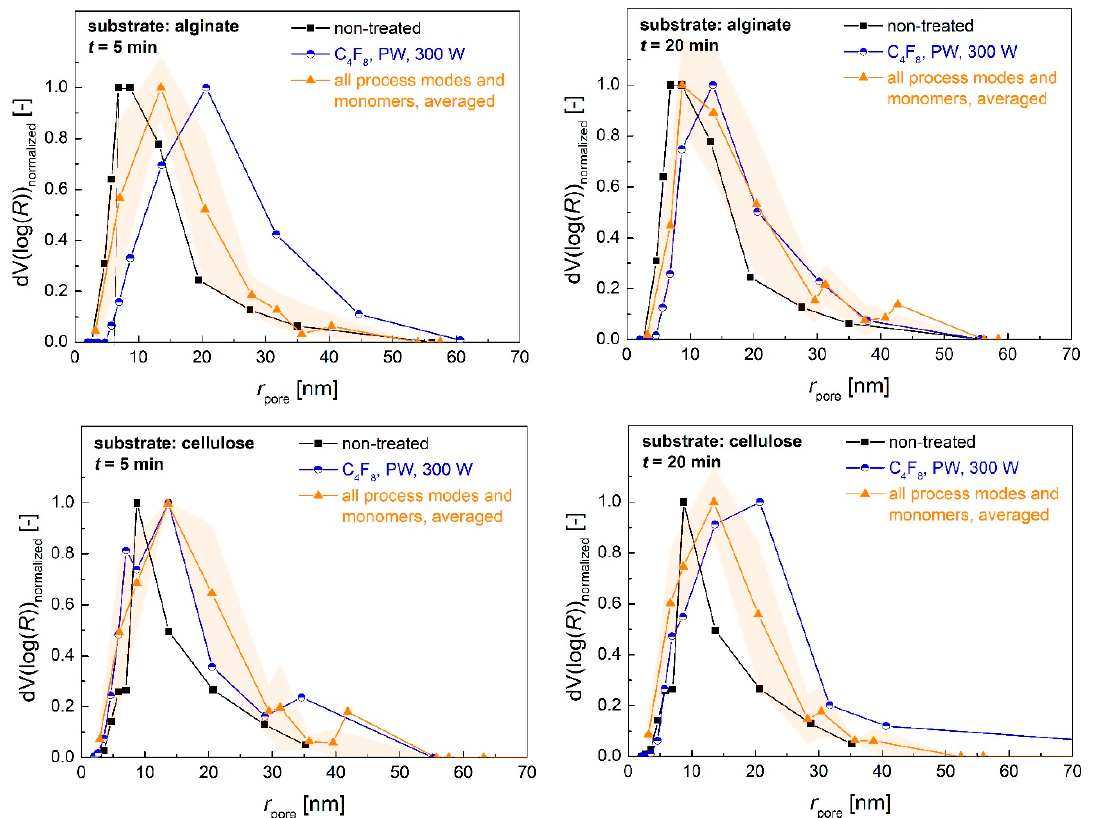
Figure 8. Comparison of BJH pore size distributions (normalized) from alginate ( top ) and cellulose ( bottom ) aerogels prior to and after the plasma coating process. Round data points represent the values obtained after coating with C 4 F 8 in PW mode with p input = 300 W; triangular data points represent the averaged values obtained after all other coating process conditions, excluding PFAC-8 coating in CW mode with p input = 90 W. Error areas represent the standard deviation from averaged values.